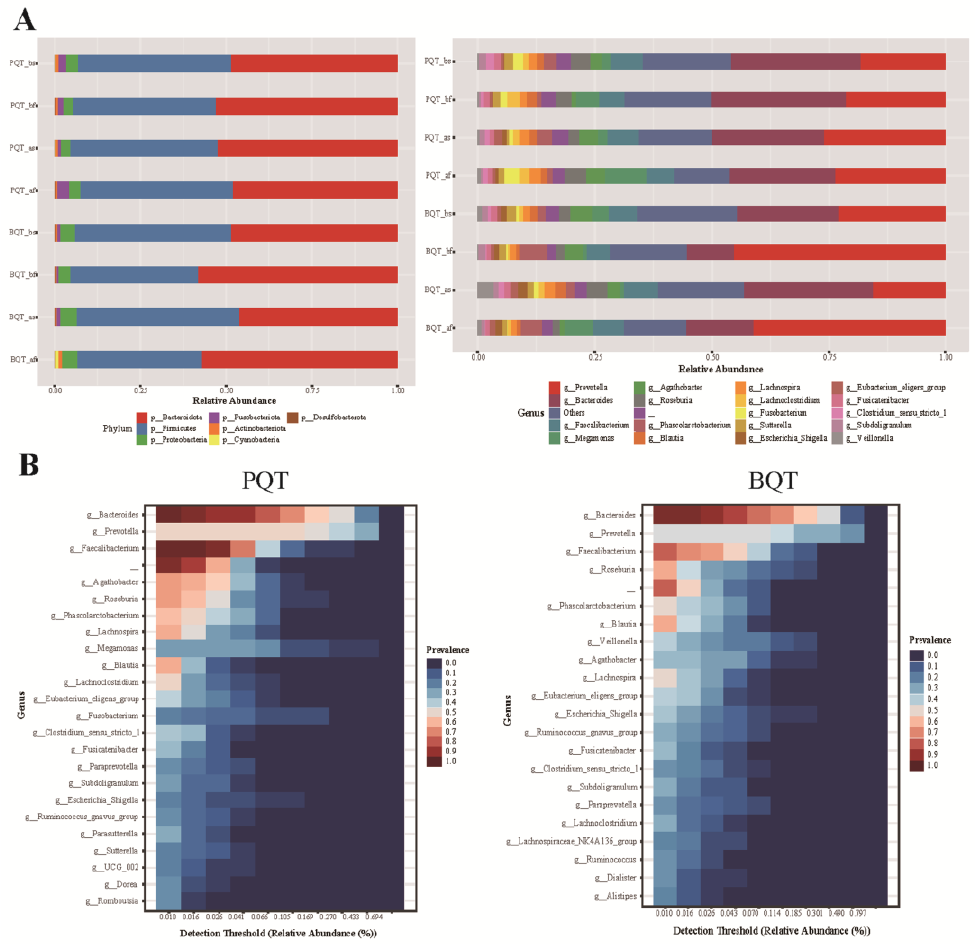
Figure 4. Taxa difference in gut microbiota between the PQT and BQT groups. ( A ) The relative abundance changes of phylum and genus in different groups. ( B ) The core microbiota composition between the PQT and BQT after treatment. Table 3. Taxa difference comparisons in gut microbiota between PQT and BQT after anti- H. pylori treatment.